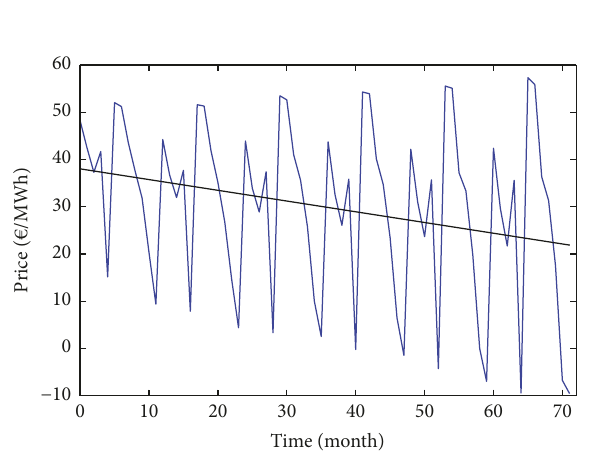
Figure 4: Average monthly wholesale power market prices gener- ated by the model (the underlying data input is given in the case study Section 5). The line represents a linear fit to the